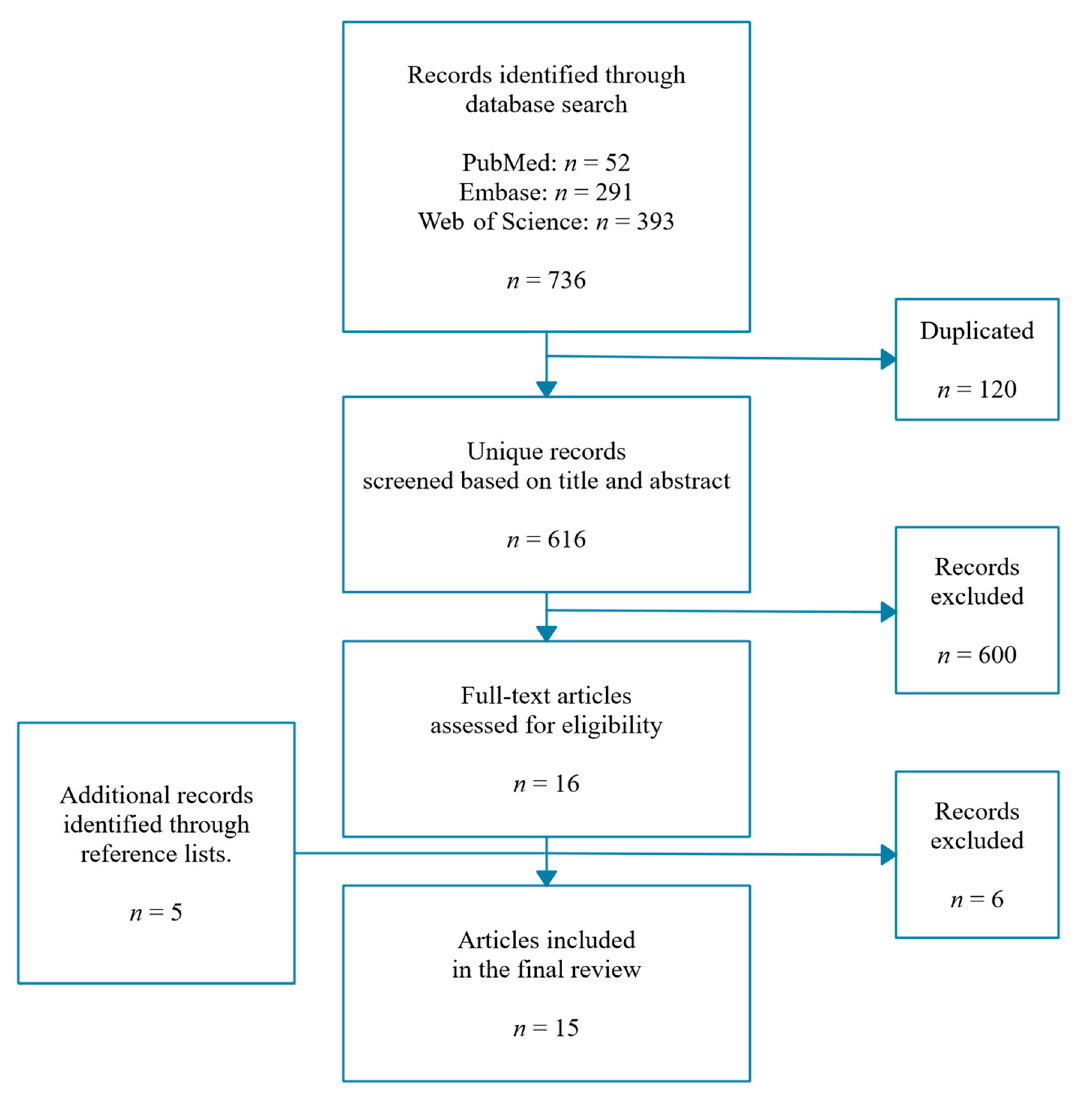
Figure 1. Flow diagram showing the results of the systematic literature search.